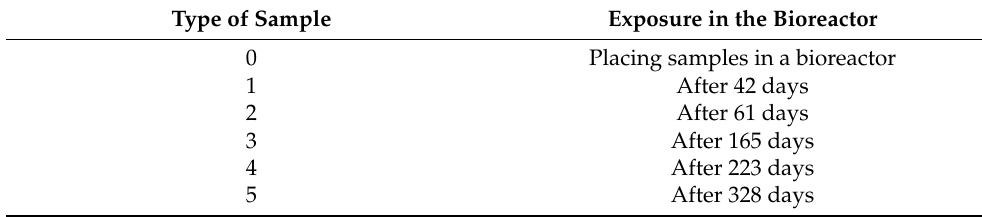
Table 2. Exposure times of test samples.